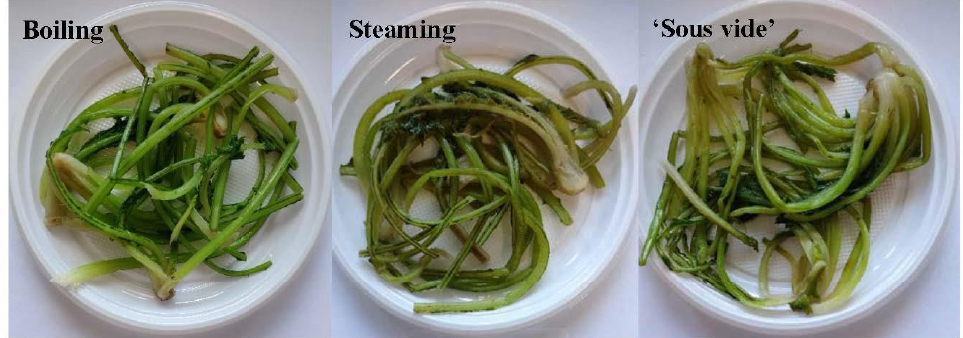
Figure 8. Golden thistle midribs cooked with different methods: boiling, steaming, and ‘sous vide’.